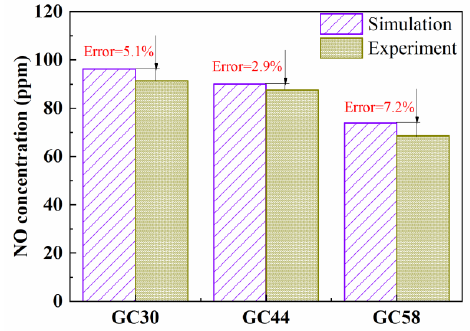
Figure 12. NO concentration at the furnace outlet.